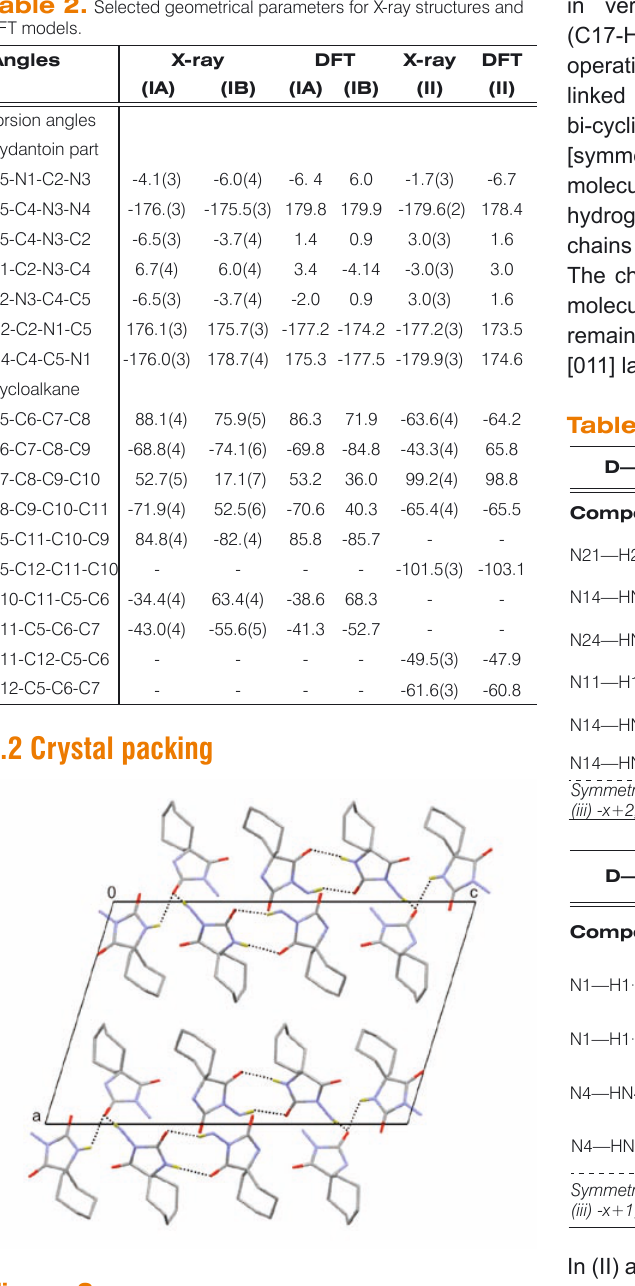
Figure 2. A view of the molecular packing in (I). Hydrogen bonds are represented by dotted lines. All H atoms except those involved in hydrogen bonding interactions have been omitted.